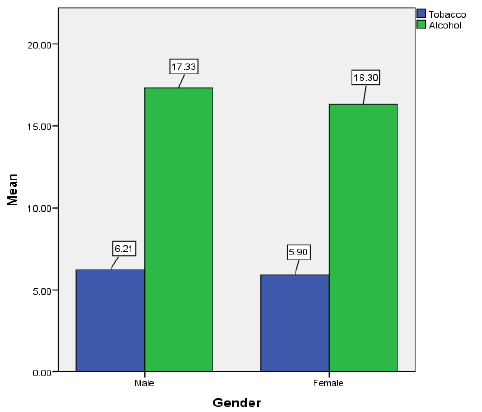
Figure 9. Gender di ff erences for tobacco and alcohol consumption. Figure 9. Gender differences for tobacco and alcohol consumption.